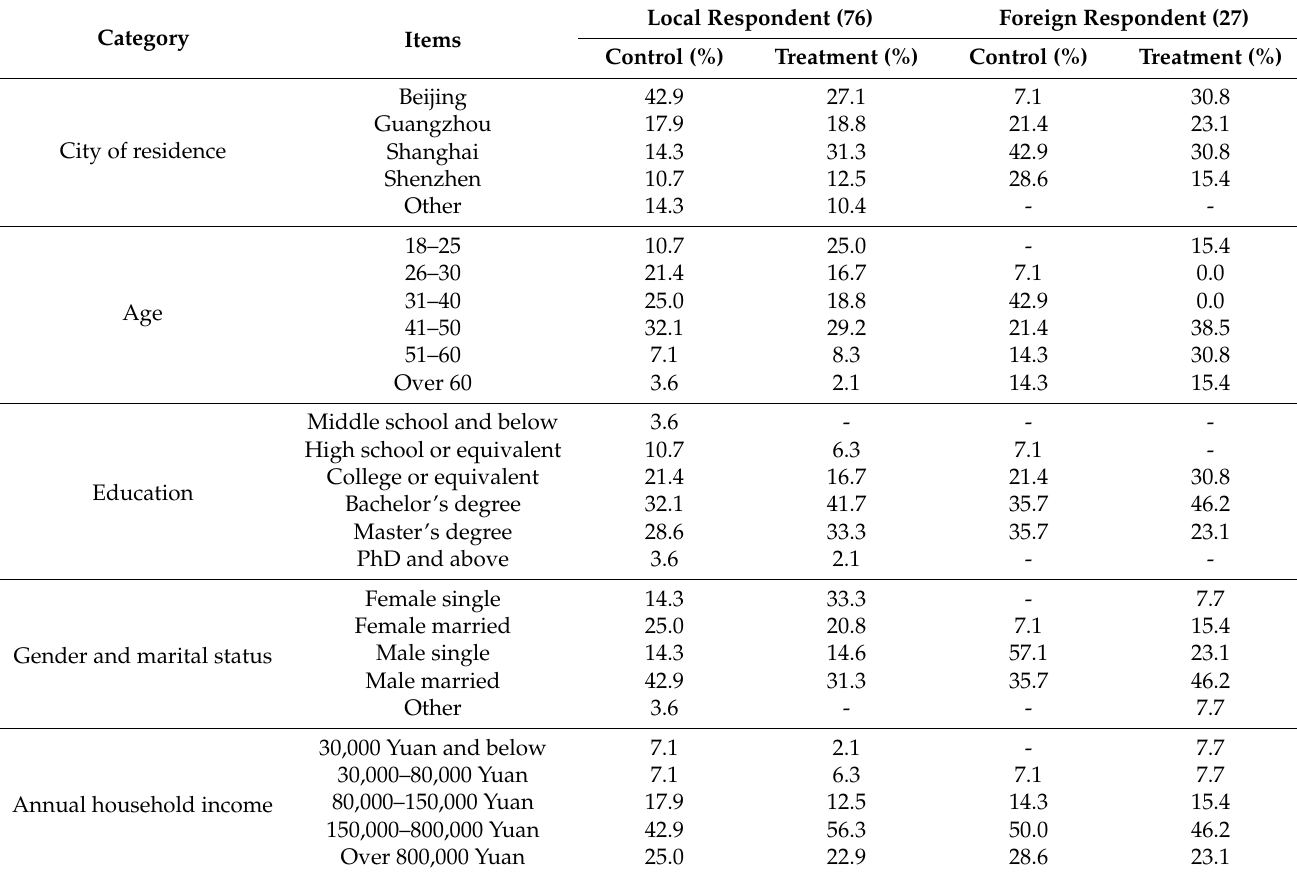
Table 2. Characteristics of the 103 local and foreign